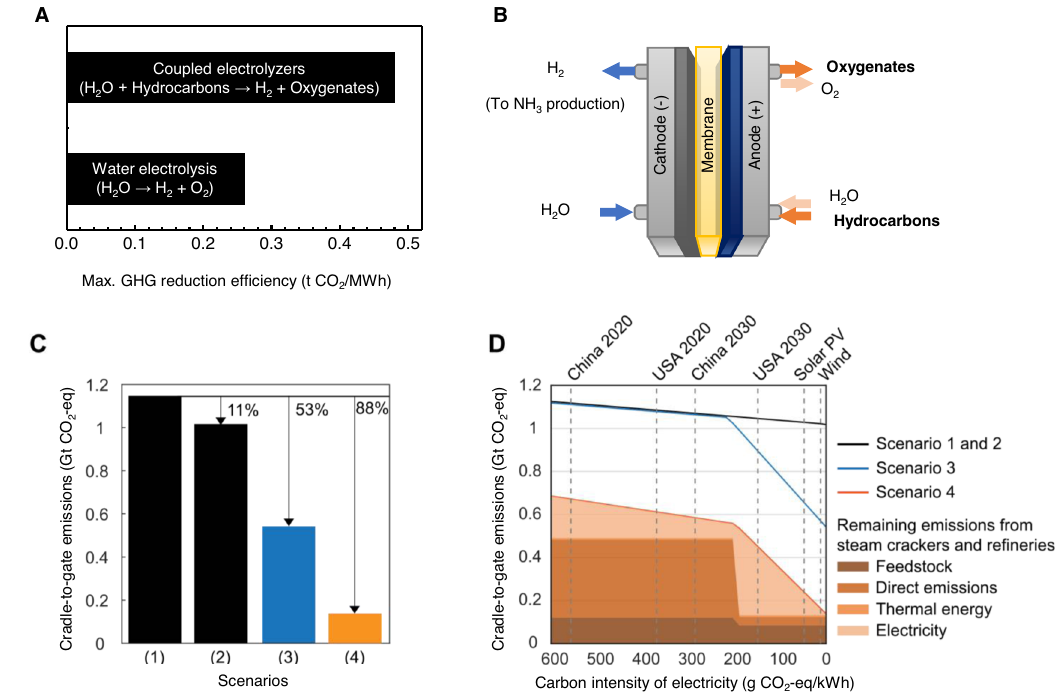
Fig. 2 | Greenhouse gas reduction potential of anodic hydrocarbon-to- oxygenate conversions. A Maximum greenhouse gas reduction ef fi ciencies per MWh electricity of water electrolysis and coupled electrolyzer technologies. B An electrolyzersystemthatcouplescathodichydrogenevolutionreactionwithanodic hydrocarbon-to-oxygenateconversionunderambientconditions. C Annualcradle- to-gateemissionsofNH 3 manufactureand hydrocarbon-to-oxygenateconversions in four scenarios: (1) continuing to use fossil-based technologies, (2) using elec- tricityonlyfrom renewablesources,withoutfurtherchangesto themanufacturing